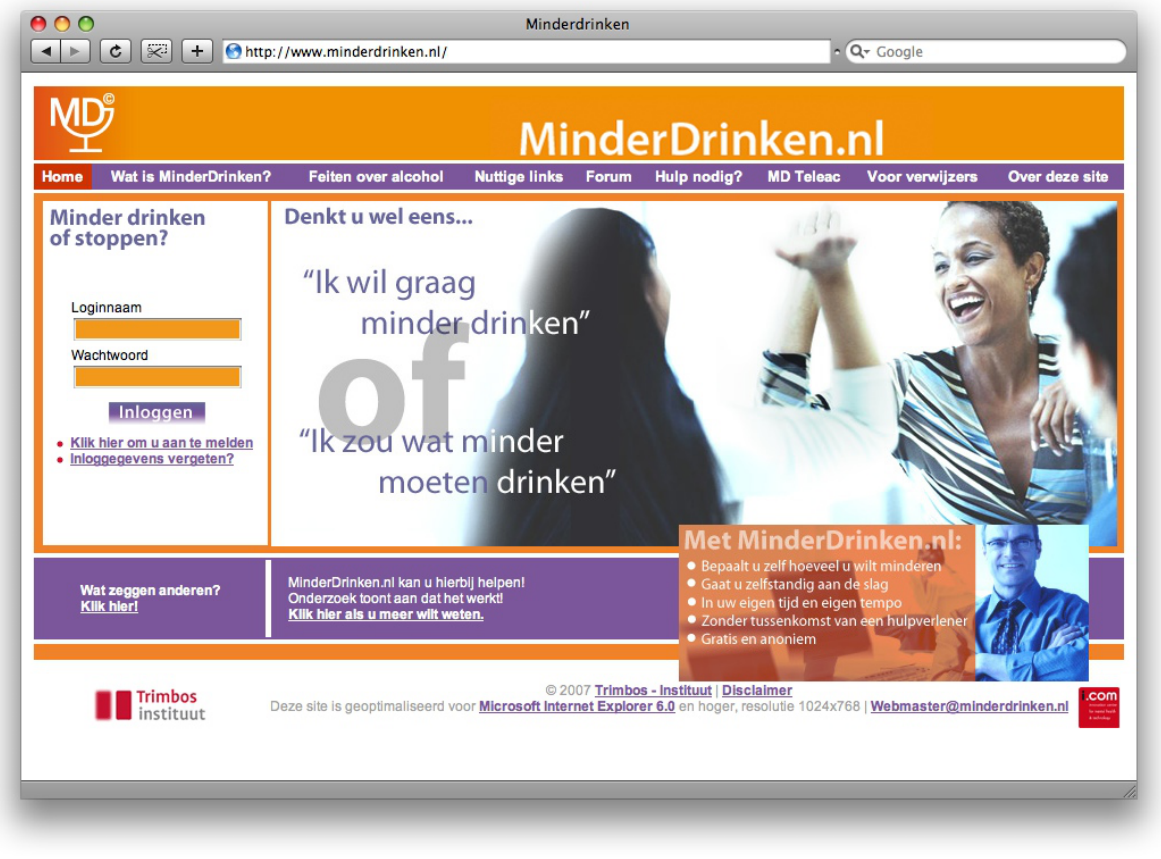
Figure 2. Drinking Less home page